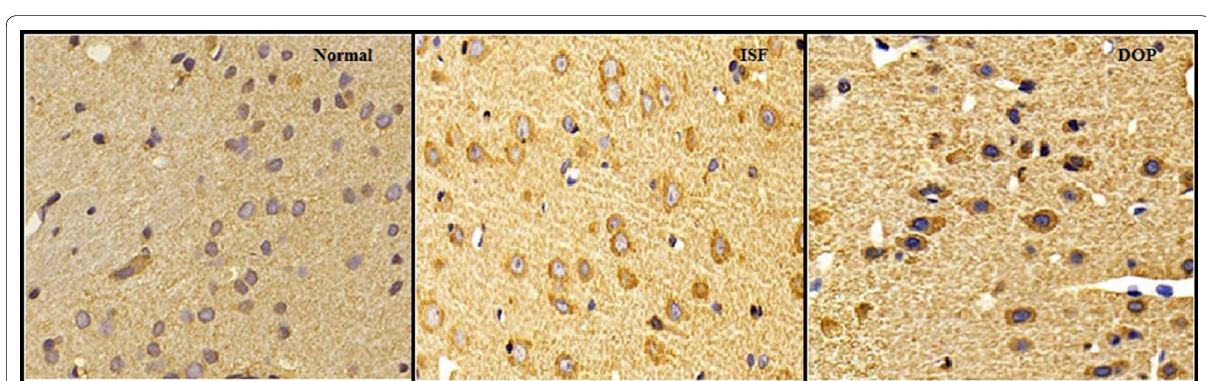
Fig. 8 Desoxyrhapontigenin ameliorates the protein expression of Sirt-1, according to immunohistochemical analysis, in the brain tissues of rats with anaesthesia-induced neuronal